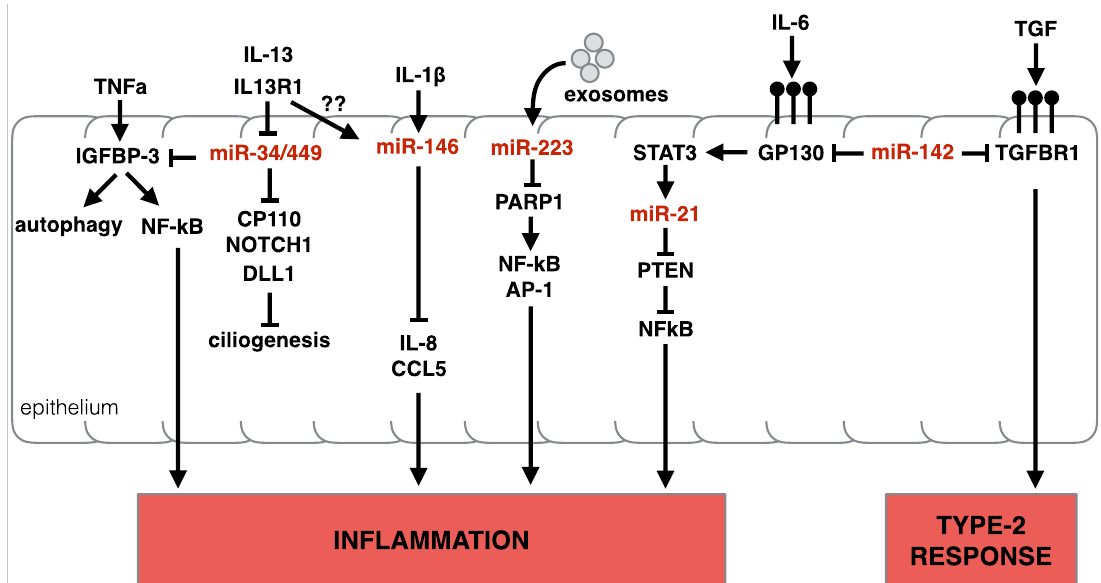
Figure 5. Type-2 related miRNAs in epithelial cells. Epithelial cells represent the first barrier to respond to stimulation and insult from the environment. In type-2 immunity, epithelial cells in mucosal barriers are particularly relevant and essential players in the initiation of an immune response.